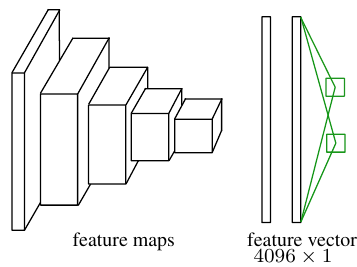
Figure 8. Changes for fine-tuning the VGGNet on the classification task. The classification layer and the corresponding weights get replaced by a two element classification layer with weight matrices of the corresponding